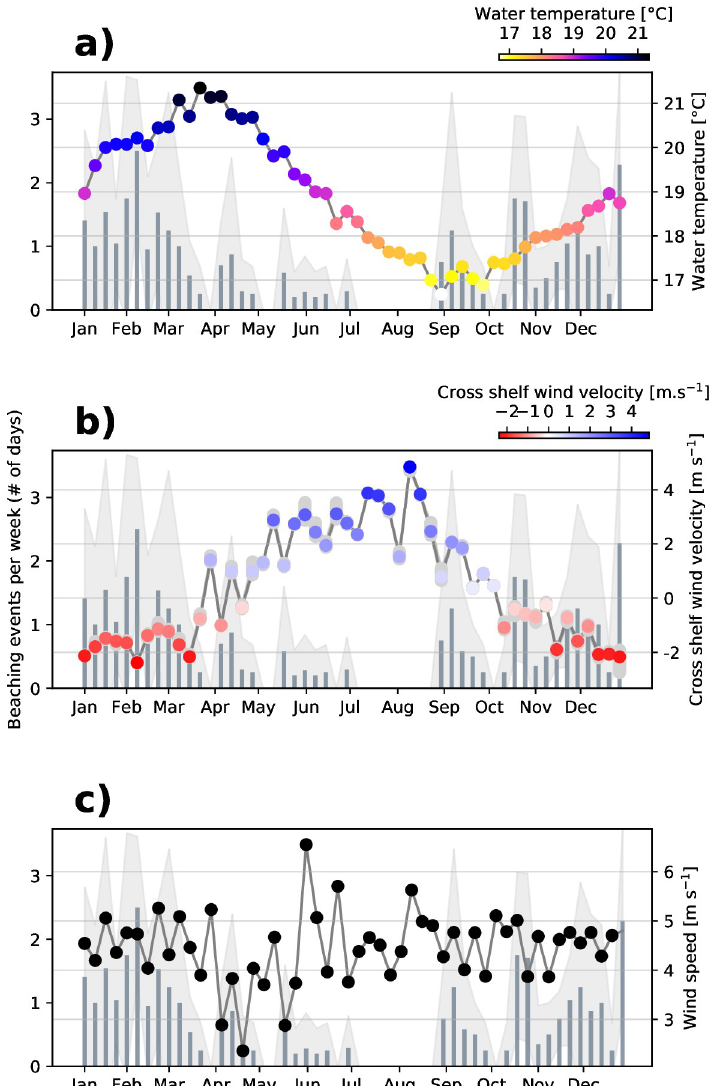
Fig 5. Weekly climatology of beaching events and environmental variables at Maroubra. Grey bars on all panels show the number of beaching events per week over 2016–2020 and the standard deviation is shown in light grey shading. In panel a, the weekly mean water temperature is overlaid (right axis and colours). In panel b, the weekly mean cross-shore wind velocity component is overlaid (right axis and colours) with positive (negative) values showing wind from (towards) the coast. In panel c, the mean weekly wind speed is overlaid (right axis). https://doi.org/10.1371/journal.pone.0265593.g005 Table 1. Outputs of a backward step-wise GEE analysis with the binary beaching event variables at Maroubra and Coogee concatenated as the response variable. Predictors are the lagged wind zonal and meridional components, the water temperature, wave height, rip currents estimates, the ocean currents zonal and meridional components, a